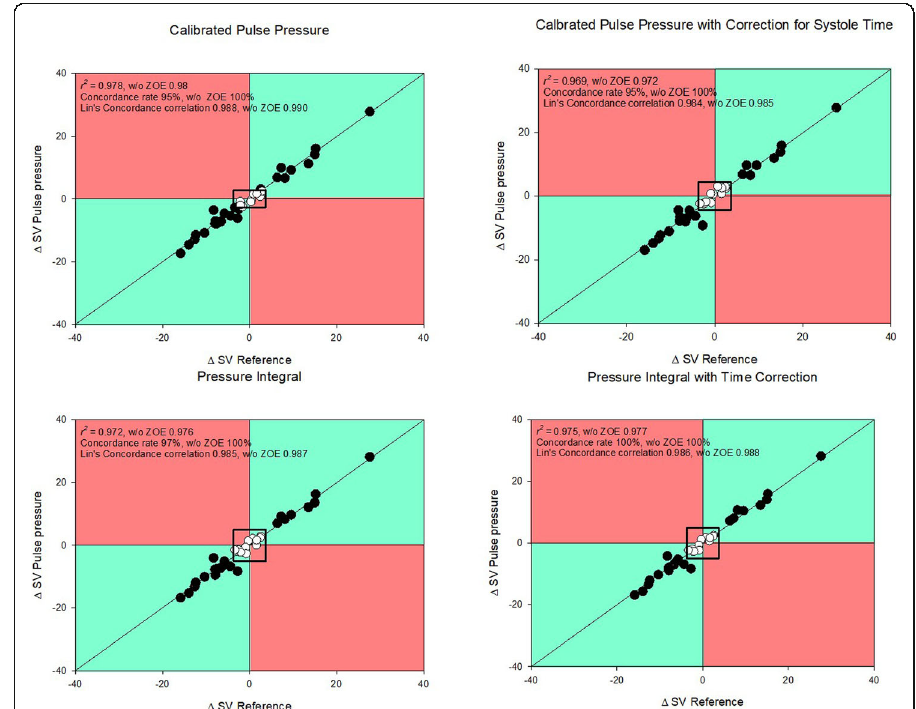
Fig. 3 Four quadrant plots for trends in stroke volumes. One hundred stroke volumes per animal and condition were averaged, and the stepwise difference between the experimental conditions calculated. Thirty-four such comparisons could be made. The central zone of exclusion contains values within the range of the least significant